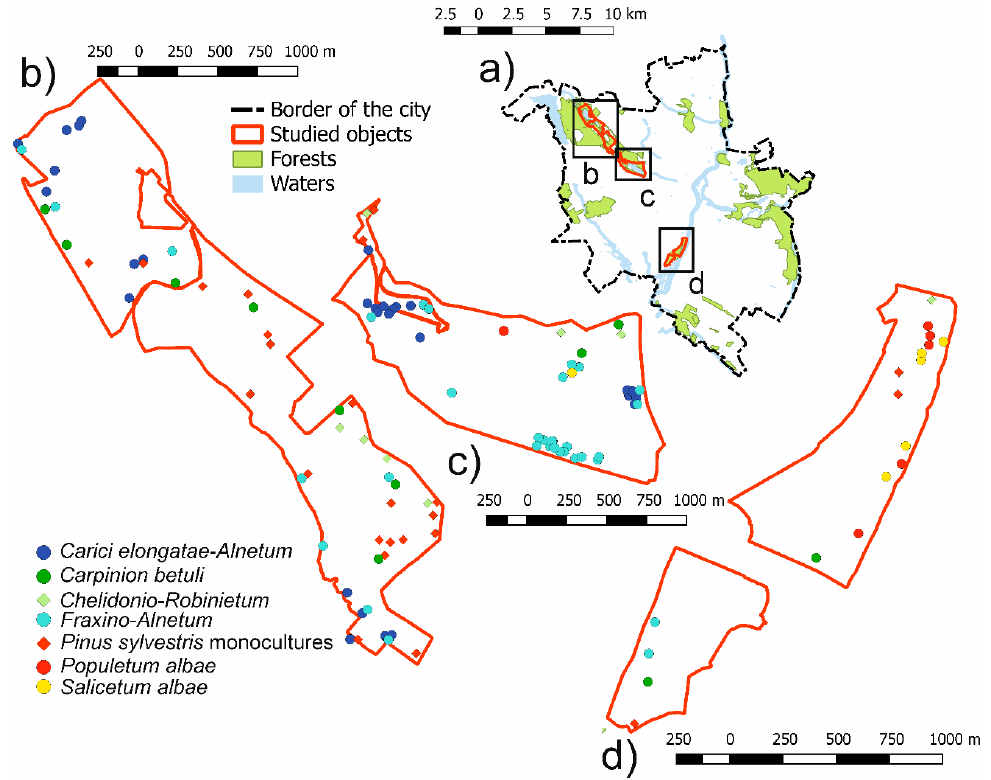
Figure 1. Localities of study sites within the study area ( a ), localities of study plots within study sites: Strzeszyn and Bogdanka ecological lands ( b ), forests around Rusałka lake ( c ), and ecological lands “D ę bina I” and “D ę bina II” ( d ). Colors of dots represent vegetation types assigned to each study plot.